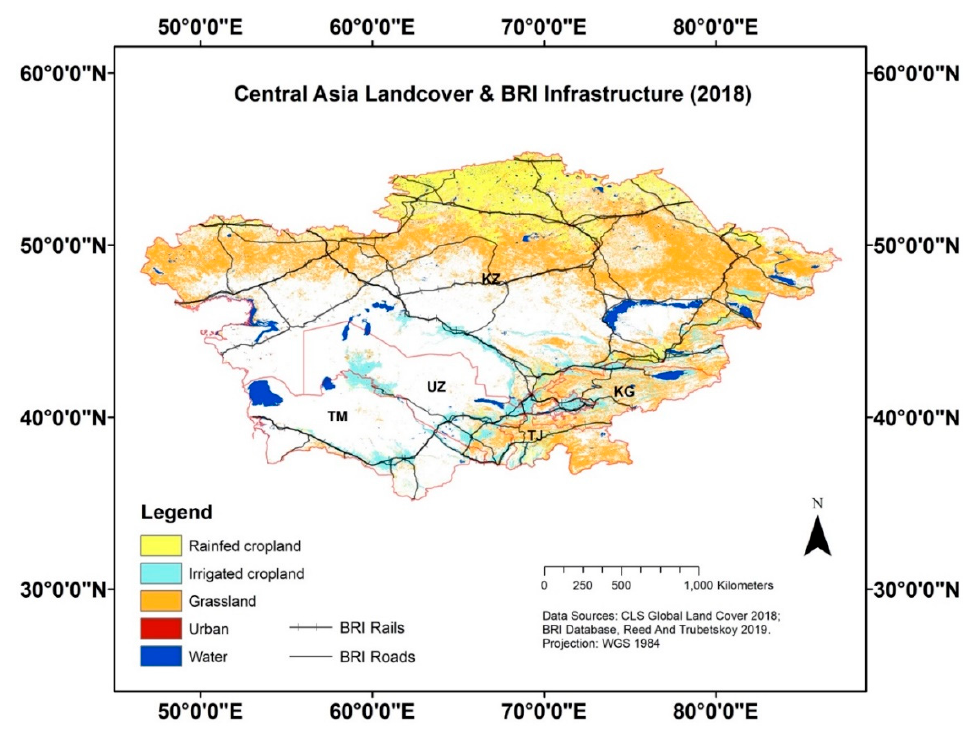
Figure 2. Roads and railways in Central Asia, 2018. Table 5. Length of rail lines in Central Asia, 2008–2018